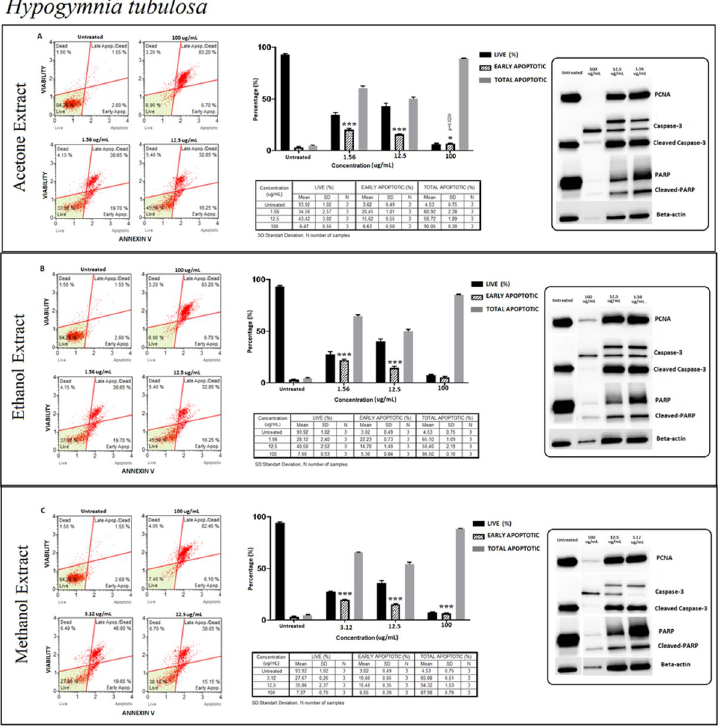
Fig 8. Hypogymnia tubulosa (HT); Annexin V/7’AAD staining flow cytometry results (scatterplots), statistical analysis (bar graphs), ± SD changes between experiments (tables) and protein levels of PCNA, caspase-3 and PARP by western blot (right panel) on PC-3 cells with three different extraction of acetone (results compiled in A), ethanol (results compiled in B) and methanol (results compiled in C) respectively. Annexin V/7’AAD staining by flow cytometry of HT on PC-3 cells was shown to induce apoptotic cell death by mainly early apoptosis. The gating was adjusted according to the untreated sample and the representative scatterplots were presented as the percentage of cells that were viable (Ann-V − and 7-AAD − ), early apoptotic (Ann-V + and 7-AAD − ), late apoptotic (Ann-V + and 7-AAD − ), and dead (Ann-V − and 7-AAD + ). Scatterplots are shown for untreated, 100 μ g/mL, 12.5 μ g/mL and 1.56 μ g/mL after 72 hours treatment with acetone extract (A) and ethanol extract (B) as well. For methanol extract treatment, groups are untreated, 100 μ g/mL, 12.5 μ g/mL and 3.12 μ g/mL after 72 hours treatment (C). The 100 μ g/mL concentration is determined as toxic dose for all extract group. Results were analyzed and presented as percentage of three independent experiments of live, early apoptotic and total apoptotic after treatment (bar graphs). Flow cytometry was shown to induce apoptotic cell death by mainly early apoptosis. The significance of only early apoptosis for each concentration indicated with an asterisk and the p value was only presented when the significance level of early apoptosis rate is between 0.05 and 0.01. ± SD changes between apoptosis assays were indicated as the mean value and SD changes per concentration and per group of live-early apoptotic-total apoptotic separately (table). Western blot results of proliferating cell marker PCNA and apoptosis-related proteins (right panel) were presented. Dose-dependent PCNA, cleavage of caspase-3 and PARP respectively. Remarkably, apoptosis rate significantly increased with the specified concentrations for all extraction and the presented results showed positive correlation with flow cytometry and western blot. In addition, the proliferation did not change significantly when compared with untreated group. � p < 0 . 05 , �� p < 0 . 001 , ��� p < 0 . 0001 (all p -values were obtained by two-way ANOVA following Dunnet’s multiple comparison